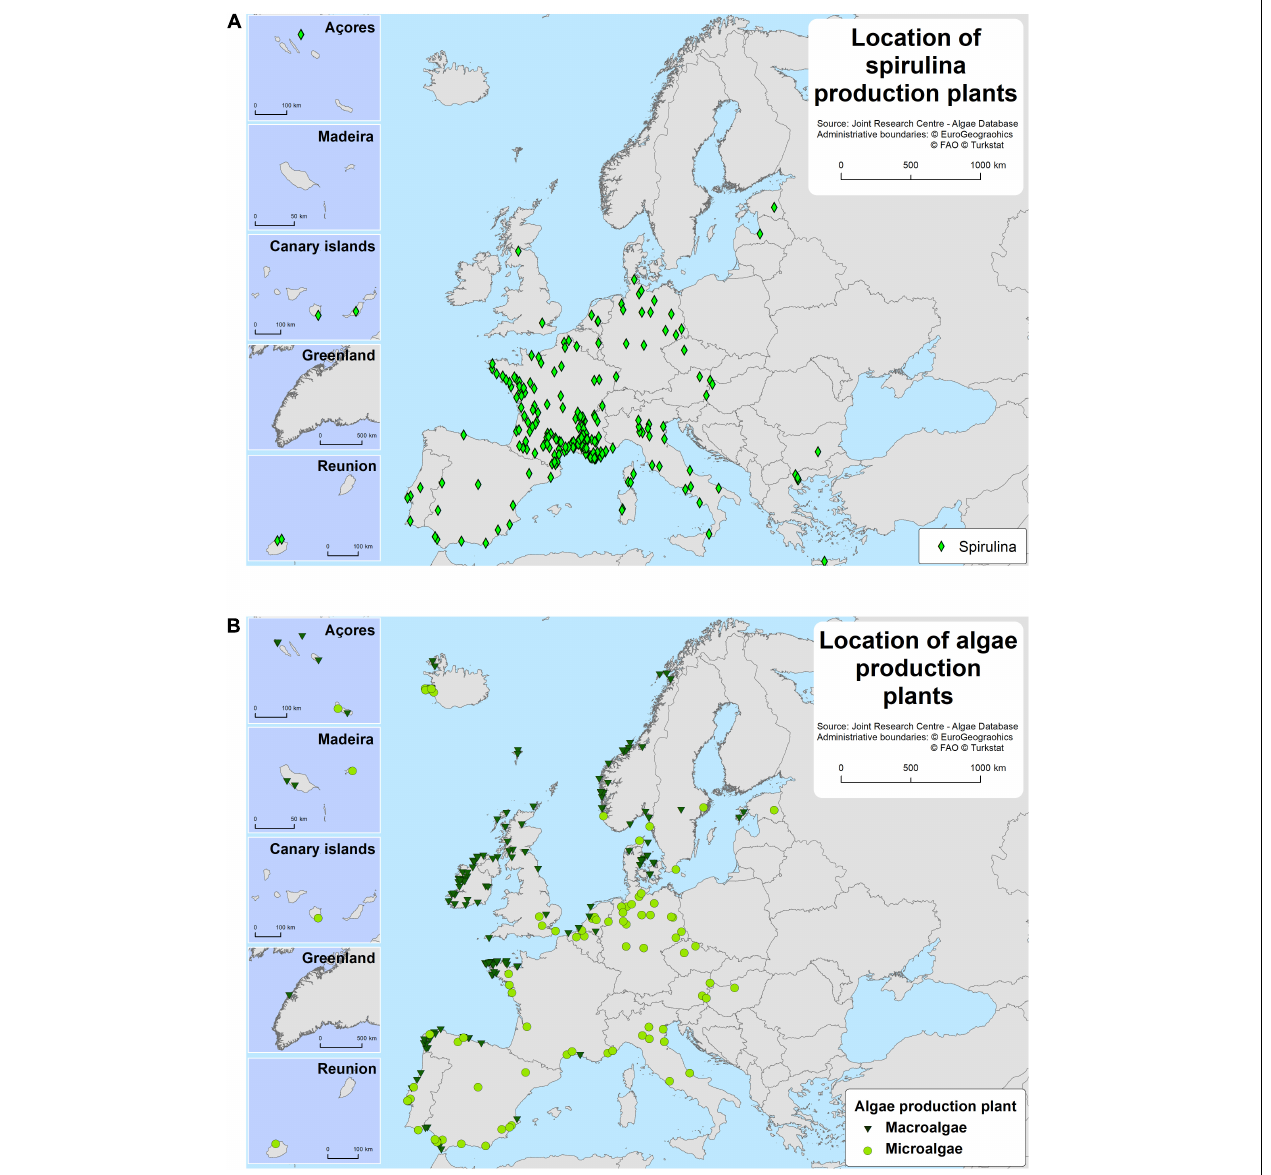
FIGURE 3 | Location of the algae (A) and Spirulina (B) production plants in